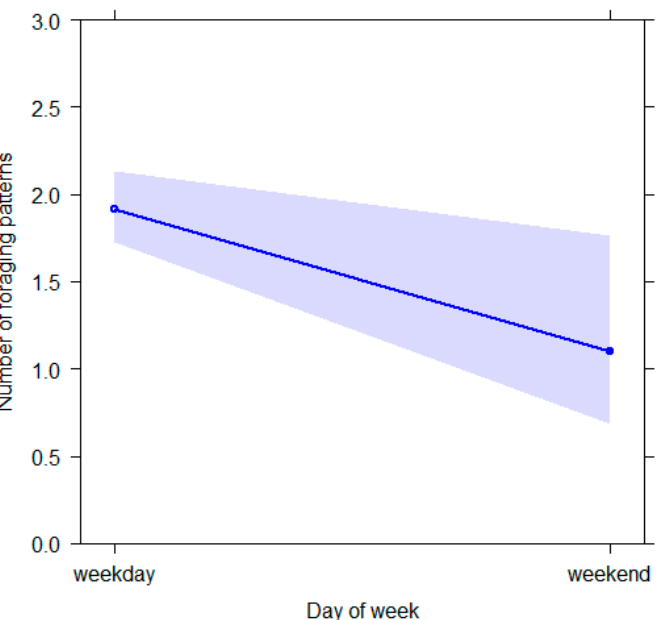
Figure 7. Effect plot of the variable having a significant influence on the number of foraging patterns. The number of foraging patterns ( Y axis) decreases during the weekend days ( X axis). The band represents the confidence interval.